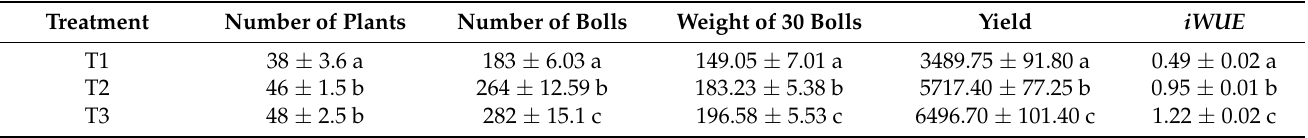
Table 5. Cotton yield components under different irrigation